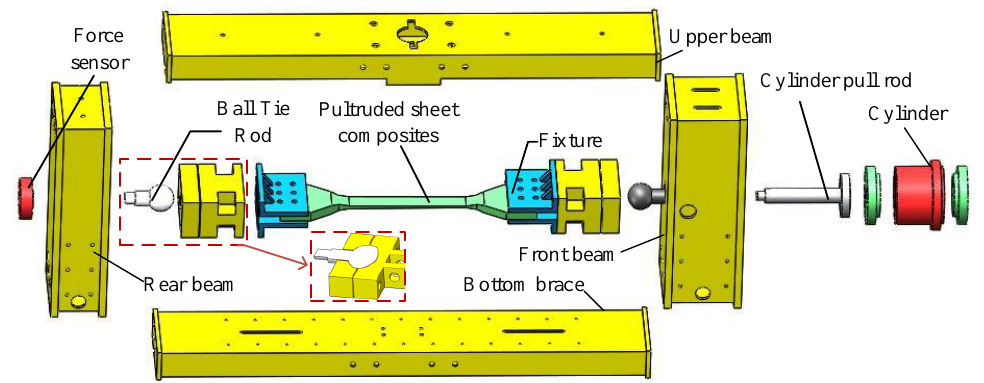
Figure 1. Test machine structure diagram.